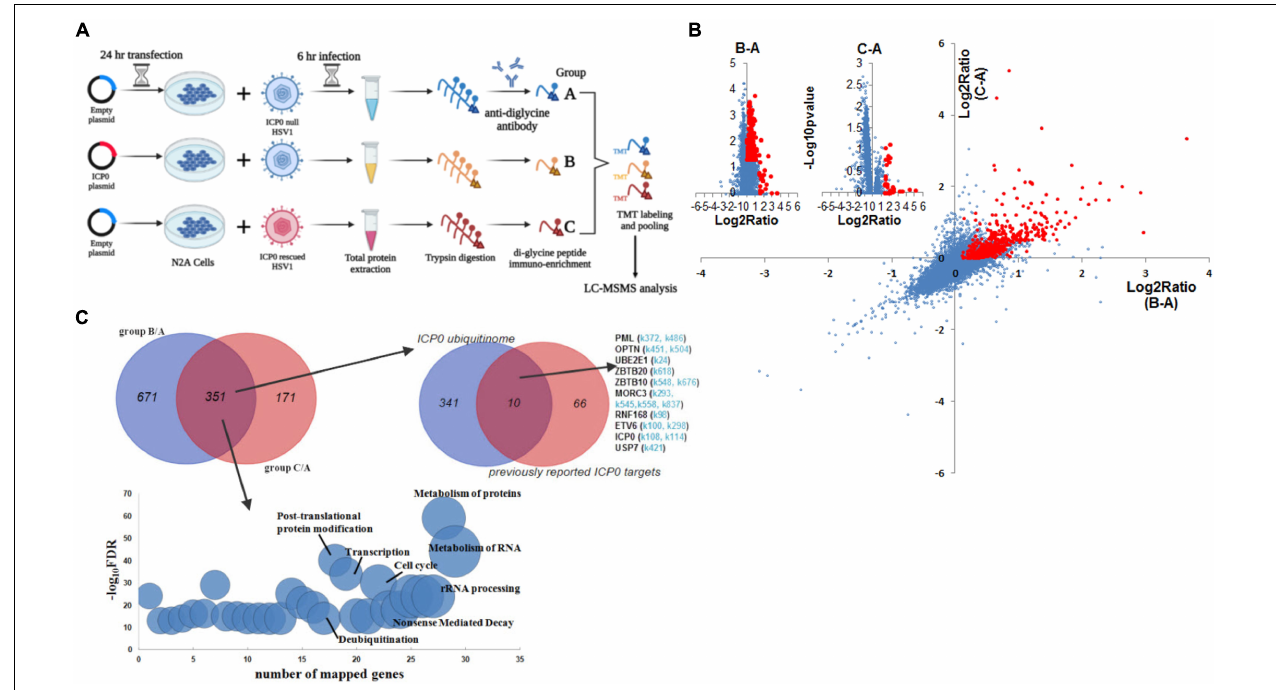
FIGURE 4 | ICP0 ubiquitinome analysis in Neuro-2a cells. (A) Schematic diagram of the experimental design for ICP0 ubiquitinome analysis. (B) Potential ICP0 target sites (red) showing higher ubiquitination levels in group B than A ( x -axis) or those showing higher ubiquitination levels in group C than A ( y -axis) according to quantitative mass spectrometry. Individual volcano diagrams showing B-A and C-A comparisons were also displayed in the upper left corner. (C) Potential ICP0 ubiquitination target proteins identified by comparing groups B and A as well as comparing groups C and A. The overlap of the two comparisons represents 351 candidate targets for subsequent analysis. The pathways enriched in these proteins are shown in the bottom graph. The upper right Venn diagram shows the overlap of our ICP0 ubiquitinome results and previously reported ICP0 substrates or interacting proteins. For the targets in our data that were also previously reported, potential ubiquitination sites on lysine differentially represented between ICP0-positive and negative cells in our data are indicated in light